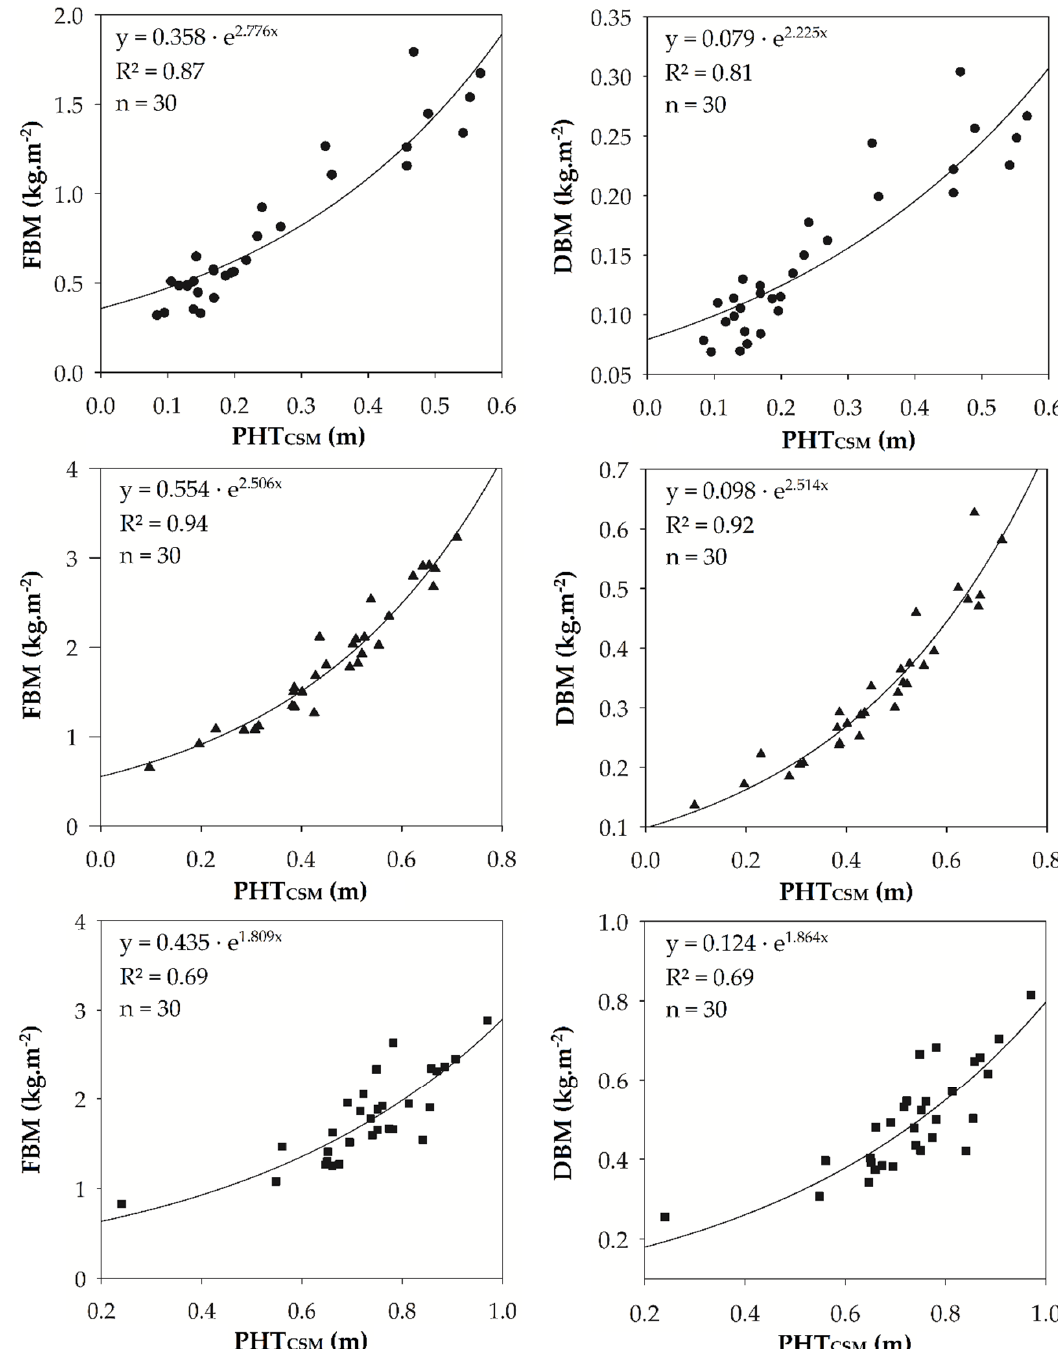
Figure 3. Regression models between FBM/DBM and PHT CSM for each mission. p < 0.001 for all R² . Symbols indicate datasets from Mission 1 ( ● ), Mission 2 ( ▲ ), and Mission 3 ( ∎ ).